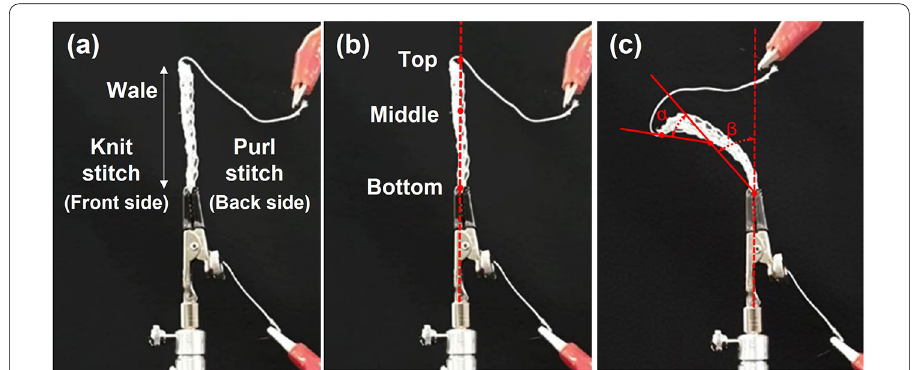
Fig. 5 Side‑view of the knitted shape memory alloy module and method for angle measurement. a Stitch composition of plain knitted pattern, b measurement points, unactuated state, and c measurement points, actuated state (α: the external bending angle of the second joint connected to the first joint, and β: the external bending angle of the first joint)